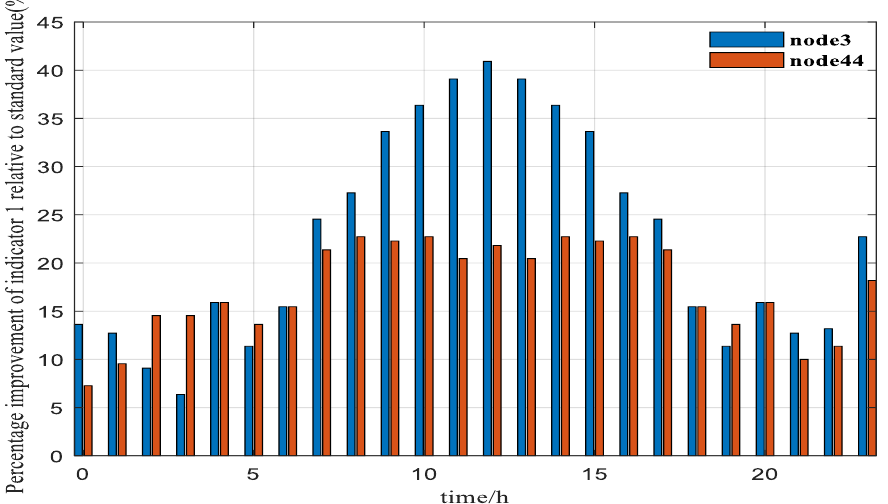
Appl. Sci. 2019 , 9 , x FOR PEER REVIEW